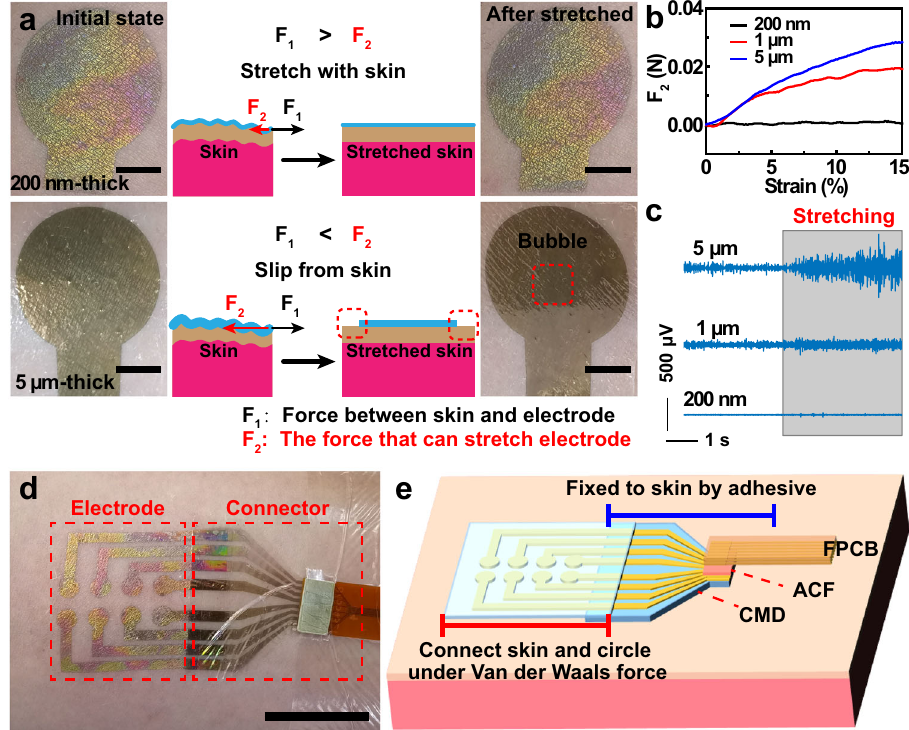
Fig. 2 Reasons for electrode stability. a Electrode − skin interface stability of the electrodes with different thicknesses after the interfaces were stretched for 100 cycles. Scale bar: 5 mm. b Forces used to stretch electrodes with different thicknesses. c Change of baseline of EMG when the electrode − skin interfaces were stretched for electrodes with different thicknesses. d Connection of the electrode with the signal acquisition equipment. Scale bar: 2 cm. e Schematic illustration showing the formation process of the connector. FPCB fl exible printed circuit board, ACF anisotropic conductive fi lms, CMD conductive medical